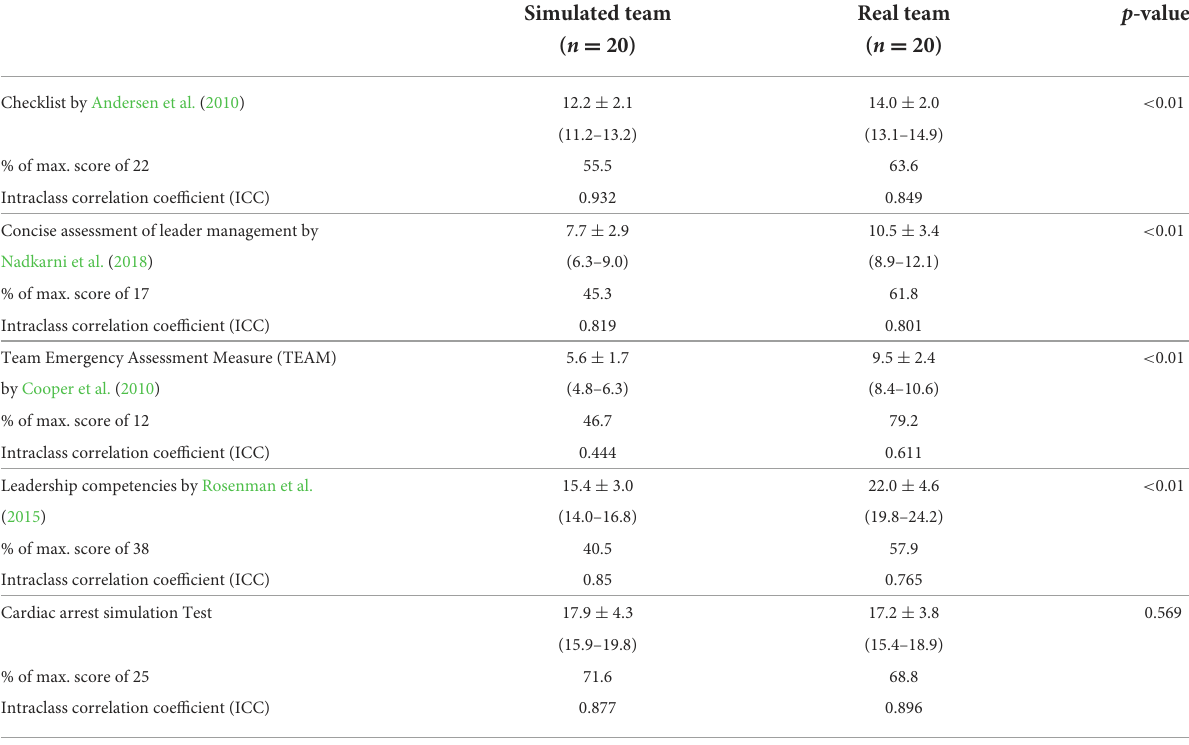
TABLE 1 Primary outcome parameter: summary score in each used checklist/tool between simulated team assessment and real team